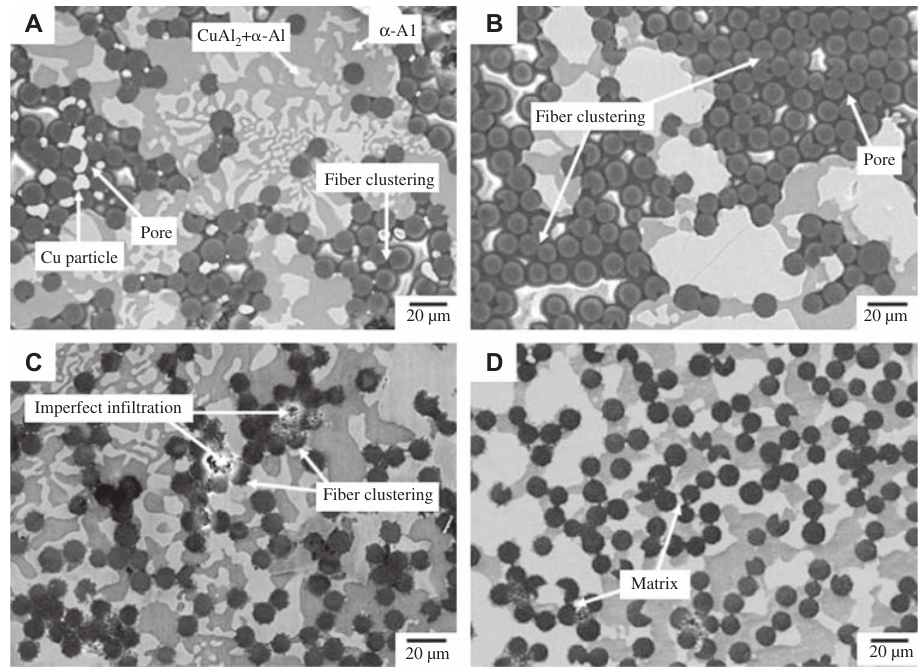
Figure 5 Microstructure of CF/Al composites depending on the added average Cu particles size of; (A) 2.55 µ m, (B) 28.86 µ m, (C) 11.79 µ m and (D) bimodal Cu particles,